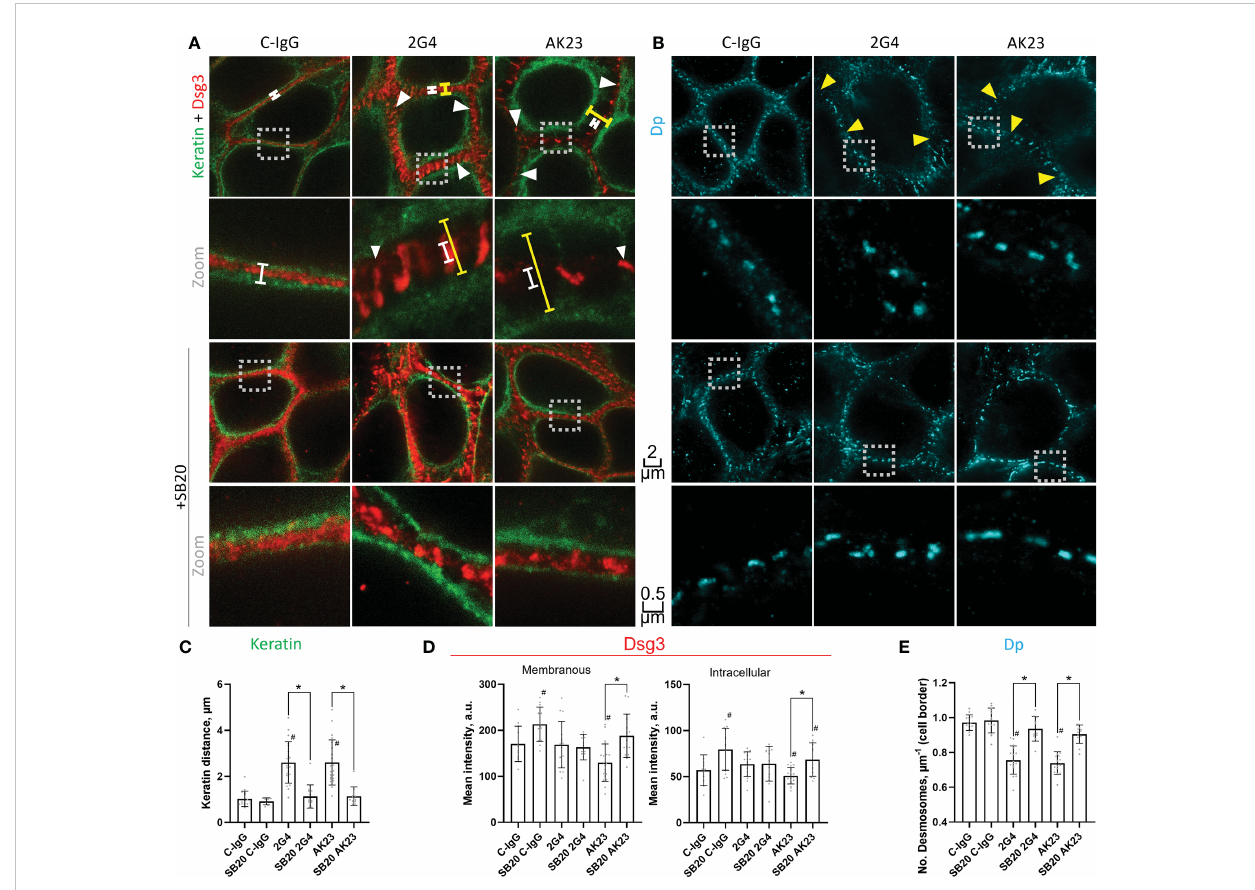
FIGURE 3 STED microscopy images reveal speci fi c pathogenic effects of 2G4 and AK23. (A) Co-staining of Dsg3 (red) and pan-cytokeratin (green) in HaCaT cells treated with either C-IgG, AK23 or 2G4 for 24 h after 1 h preincubation with vehicle or SB20 (60 µM, inhibiting p38MAPK). Spans illustrate the degree of keratin fi lament retraction (yellow) compared to control (white). White arrowheads showcase the fragmented staining of Dsg3, which is mostly associated with keratin fi laments. (B) Staining of Dp (with anti-Dp-pAb, A7169) after 24 h treatment with IgGs and 1 h preincubation with vehicle or SB20. Yellow arrowheads indicate reduced numbers of desmosomes per µm of cell border. Two different magni fi cations are shown for each condition (Scalebars as indicated, boxes with dotted outline indicate the area which was zoomed in on); Quanti fi cation of the STED images: (C) Keratin fi lament retraction form the cell borders towards the nucleus. (D) Dsg3 staining intensity at the cell borders/membranes (left) or in the cytoplasm (right). (E) Number of desmosomes per µm membrane (Experiments (N)=4-6, Evaluated images (n)=12-22). * marks statistically signi fi cant differences between the two conditions indicated, # indicates statistically signi fi cant differences towards control conditions, both in two-way- ANOVA with Sidaks correction for multiple comparisons,